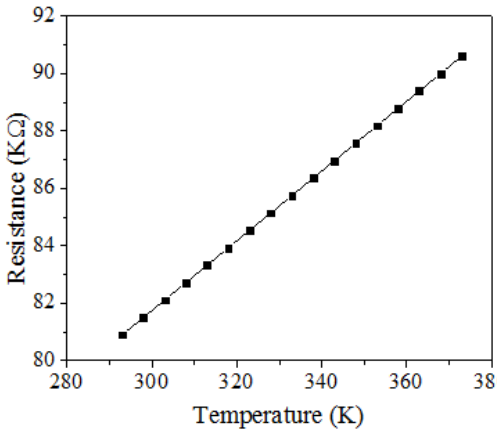
Figure 5. Evaluated resistance of the thermometer.